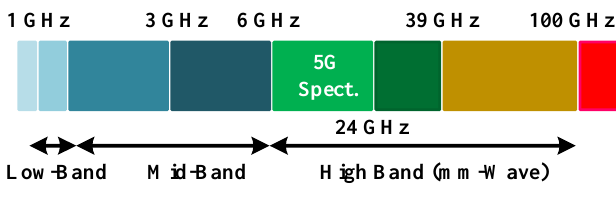
Figure 1. Frequency spectrum of the 5G.